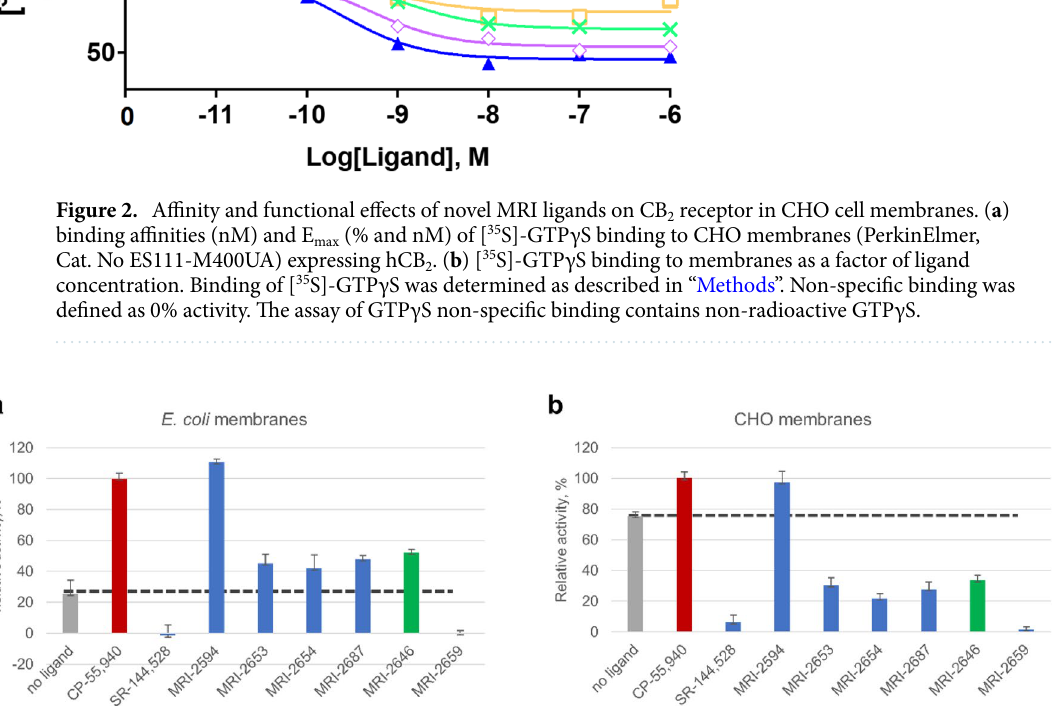
Figure 3. GEF of CB 2 expressed in: ( a ) E. coli membranes and ( b ) CHO membranes (Millipore EMD). 2 μg of total protein per assay. Each point represents an average of four independent measurements (n = 4). Ligands were added at a concentration of 2 μM to ensure saturation of the receptor, and G protein was added as described in “Methods”. The dotted line indicates the rates of activation of G protein in the absence of a ligand. The rates of activation with CP-55,9040 are set to 100%, and rates of activation in the presence of SR-144,528 to